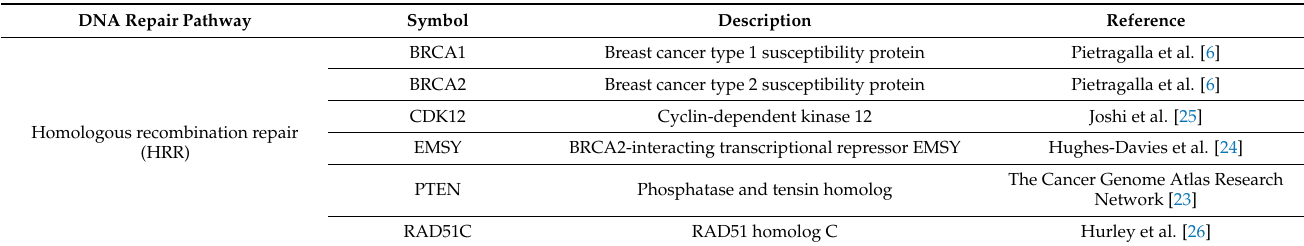
Table 1. Critical factors implicated in the repair of cisplatin-induced DNA damage. DNA Repair